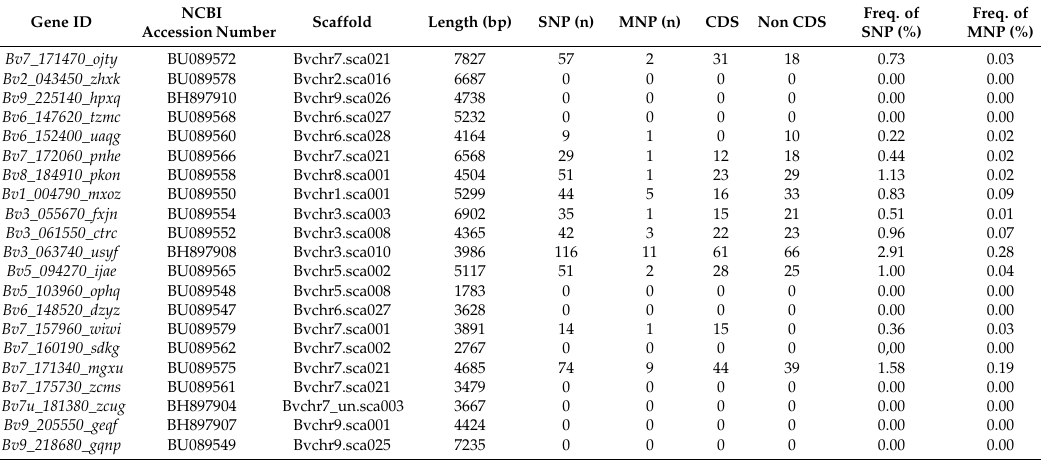
Table 2. The number and frequency (%) of SNPs and multiple-nucleotide polymorphism (MNPs) detected across 21 RGAs in beet